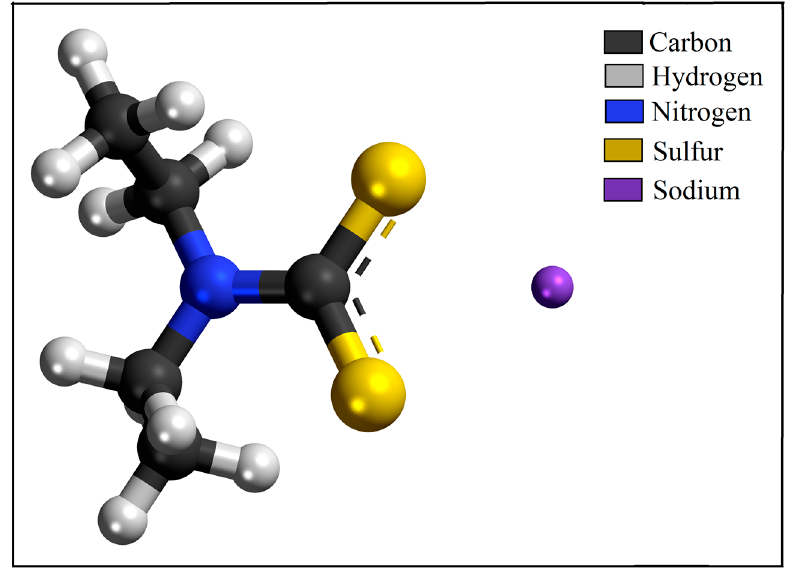
Figure 5. Sodium diethyldithiocarbamate (DETC) three-dimensional (3-D) chemical structure used as a potential anti- Leishmania sp. drug. DETC acts as a metal chelator and therefore inactivates enzymes essential for parasite survival [49,50].